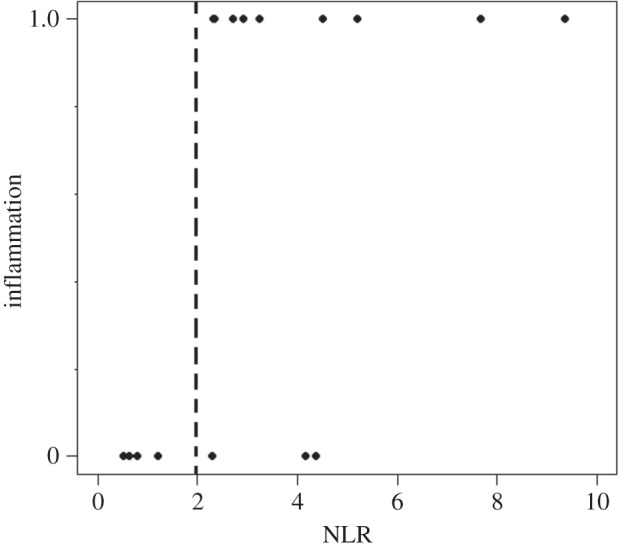
Presence or absence of swelling in terms of the NLR of six-month-old California sea lion pups.